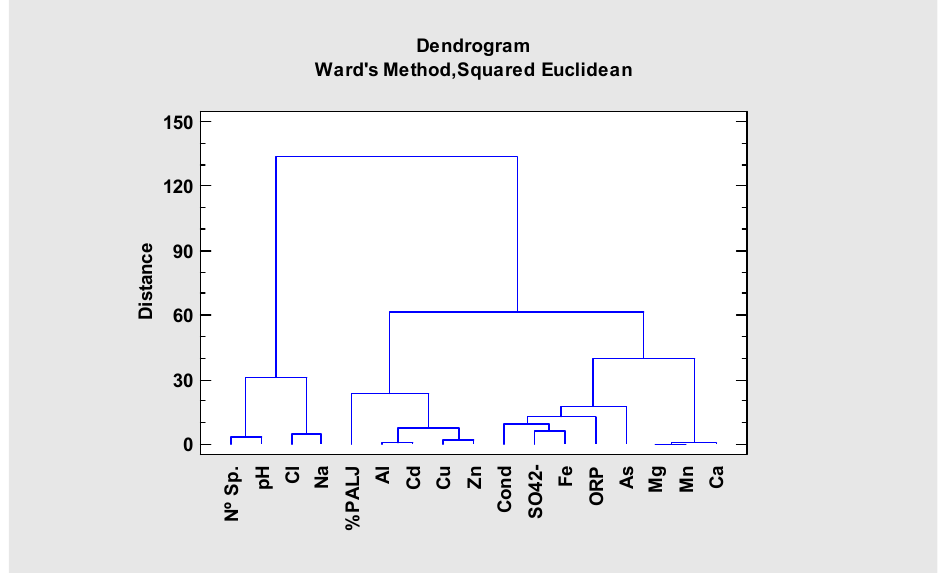
Figure 3. Dendrogram resulting from the cluster of the physicochemical and biological variables using the Ward, Euclidean Square Method.